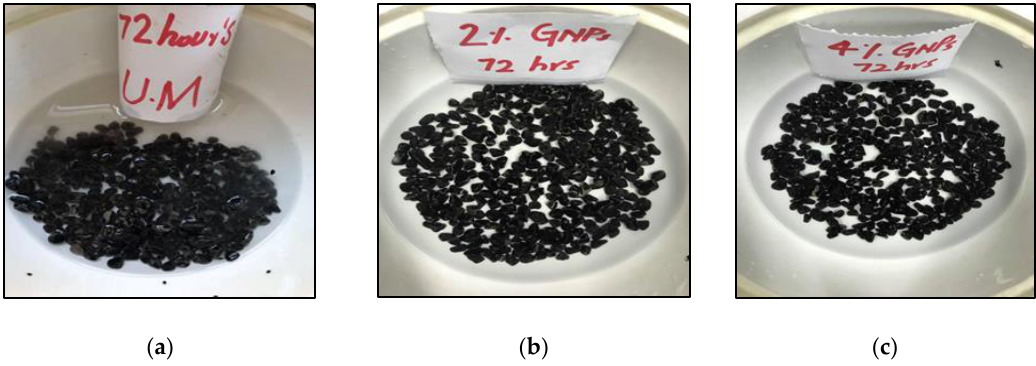
Figure 13. The bitumen/aggregate affinity after 72 h of rolling: ( a ) The base binder, ( b ) 2% Graphene Nano-Platelet (GNP)-modified binder and, ( c ) 4% GNP-modified binder.